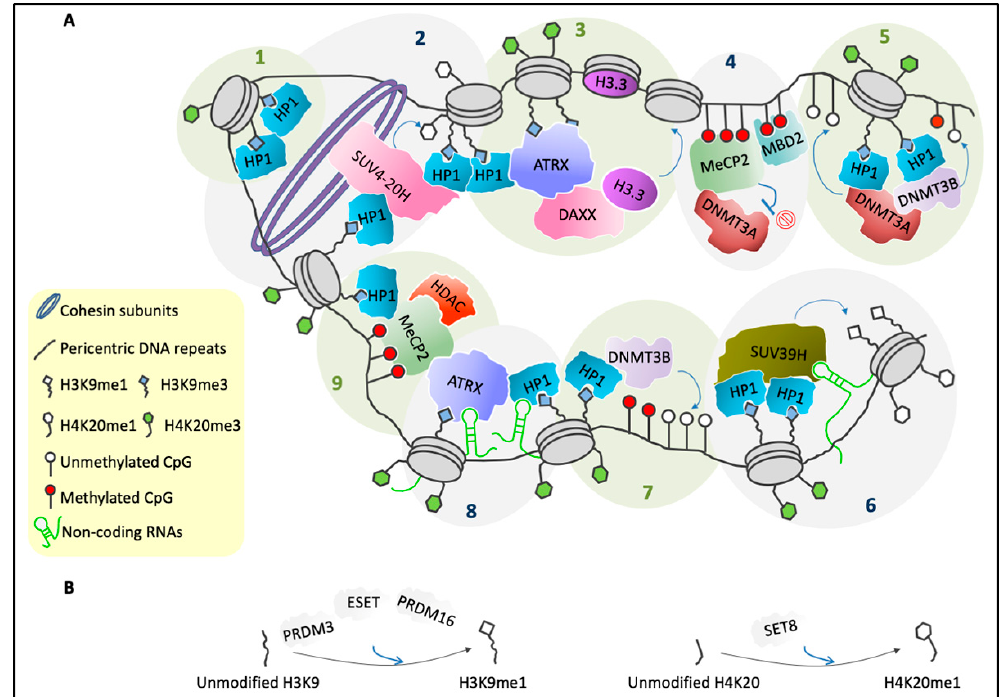
Figure 2. Several factors are involved in PCH organization. ( A ) Schematic representation of the general molecular structure of mammalian PCH during interphase. Step 1: HP1s bind to H3K9me3 and can self-interact [44]. Step 2: HP1s recruit the SUV4-20H enzymes, which can convert H4K20me1